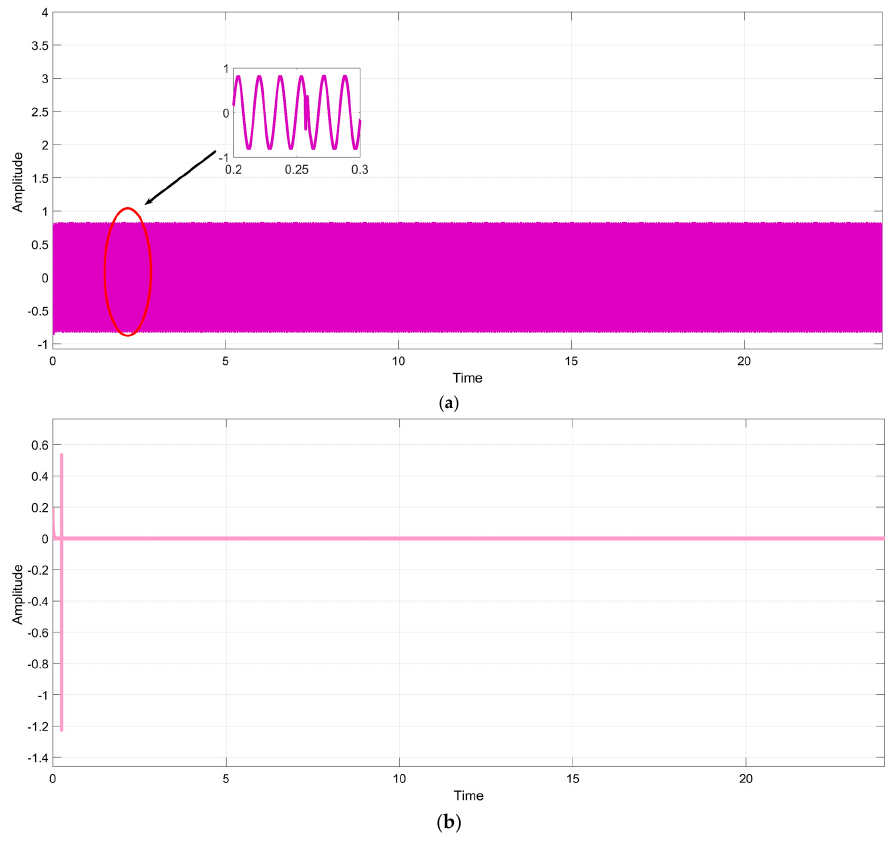
Figure 14. ( a ) The output of the PR controller, ( b ) error signal of the PR controller during the 180-degree reference change. Appl. Sci. 2020 , 10 , x